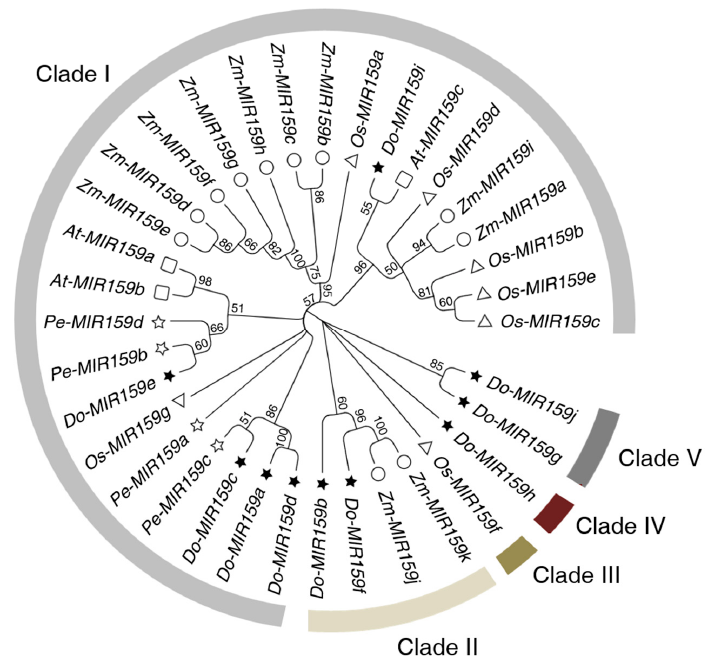
Figure 2. Phylogenetic analysis of MIR159 gene of D. officinale and other 4 representative plants of dicots and monocots. The phylogenetic tree was constructed with 35 MIR159 genes, using Maximum Likelihood Estimate method in MEGA 11. The bootstrap value was set as 1000 replicates. The MIR159 genes, 3 from A. thaliana ( Ath-MIR159s ) marked with square, 7 from O. sativa ( Osa-MIR159s ) marked with triangle, 11 from Z. mays ( Zma-MIR159s ) marked with circle, 4 P. equestris ( Peq-MIR159s ) marked with hollow star, and 10 from D. officinale ( Dof-MIR159s ) marked with black star, were clustered into 5 clades. The light grey, buff, yellowish-brown, reddish-brown, and dark grey indicated clade I to IV, respectively.